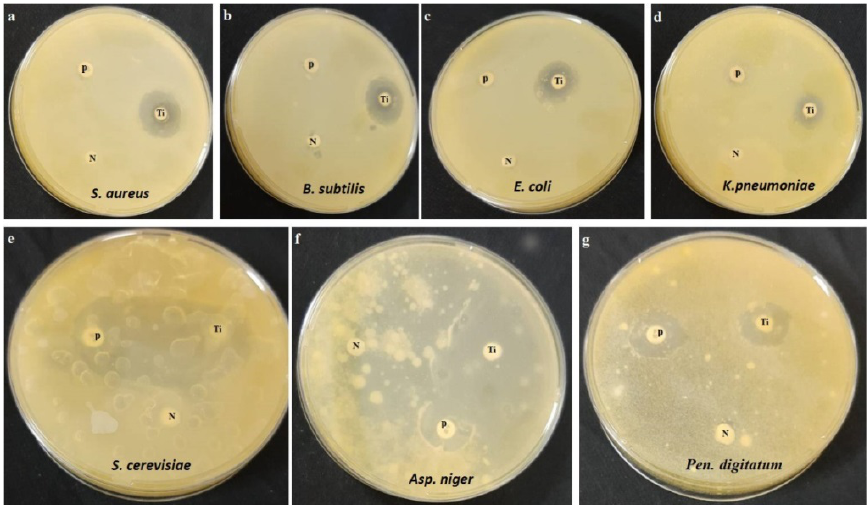
Figure 7. The antimicrobial efficacy of biosynthesized TiO 2 NPs against tested microbial strains. a